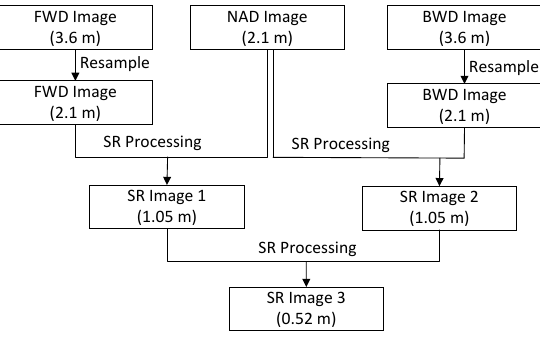
Figure 1. Workflow of ZY-3 Three Line Camera (TLC) images super resolution reconstruction.